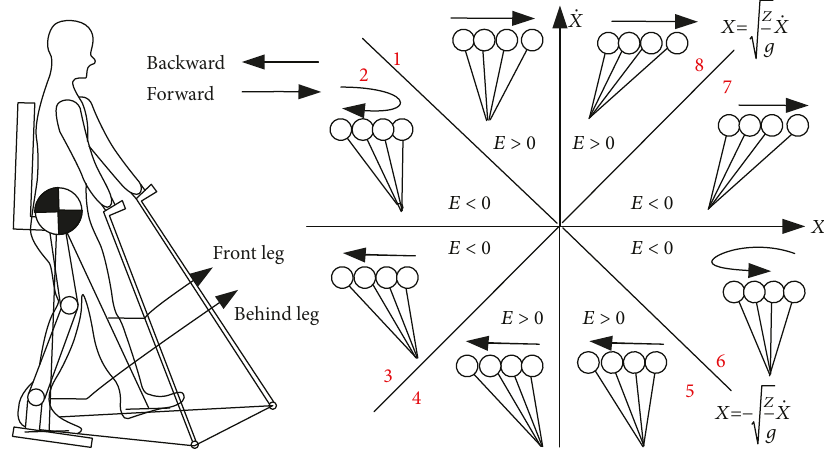
Figure 3: In double-support phase, state of human-exoskeleton system and orbital energy can be describe with the diagram with 8 quadrants.